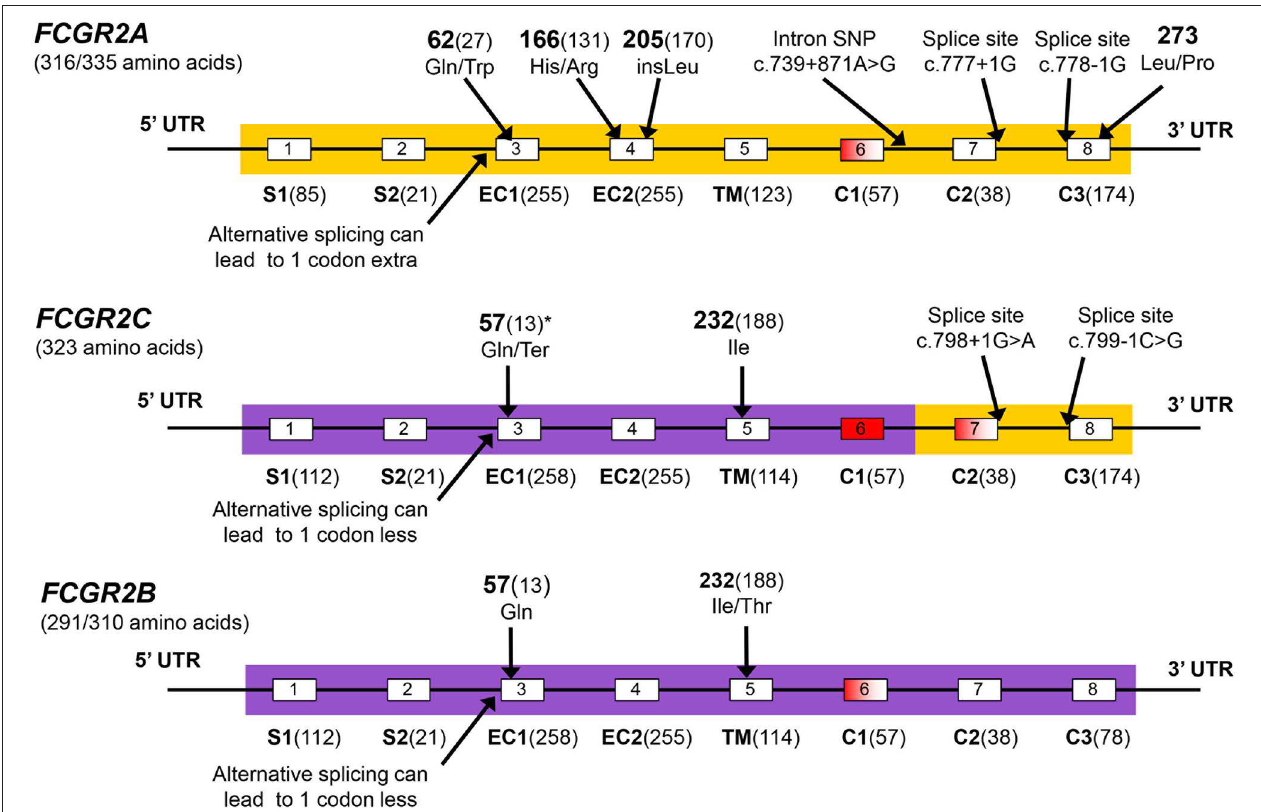
FIGURE 3 | FCGR2 exons. The FCGR2C gene is the crossover product from an unequal crossover between FCGR2A and FCGR2B . Coloring of FCGR2C matches the color of the other FCGR2 genes in the parts where it is highly homologous to that gene. Exons are shown by boxes, white exons are included in all transcripts, red exons are always spliced out, red-shaded exons are spliced out in some transcripts but retained in others. Exon names are below and followed by the number of coding base pairs in that exon. S1, S2, signal peptides; EC1, EC2, extracellular domains; TM, transmembrane domain; C1, C2, C3, cytoplasmic domains. The C3 exons contain an immunoreceptor tyrosine-based activation motif (ITAM) in FCGR2A and FCGR2C , and contains an immunoreceptor tyrosine-based inhibitory motif (ITIM) in FCGR2B . There is a potential confusion with regard to exon numbering in FCGR2 genes: In the FCGR2B gene, transcripts exist that do (FCGR2B1) or do not (FCGR2B2) retain the 57 bp exon6, dependent on the cell type in which the receptor is expressed. In FCGR2A and FCGR2C a very homologous exon6 is present on genomic level, but this exon is always spliced out in FCGR2A and FCGR2C transcripts. Only in some rare cases exon6 is retained in FCGR2A, which results in a gain-of-function Fc γ RIIA isoform (39). The final two exons of FCGR2A and - 2C are often designated exon6 and 7, but to reflect the homology between the 3 FCGR2 genes, we chose to include the potential exon6 in the nomenclature of all FCGR2 genes, designating the final 2 exons exon7 and 8. However, we do not include the base pairs of this exon6 when indicating the nucleotide positions in the FCGR2A and FCGR2C transcripts, because this is not normally done in the literature. In FCGR2A transcripts, further inconsistencies exist as a result of alternative splicing at the beginning of exon3 because of two adjacent splice acceptor sites that can both be used. The most commonly used nucleotide and amino acid numbering is derived from the shorter transcript in which the 3’ splice acceptor site is used, so we chose to use this transcript for nucleotide numbering throughout this thesis. Several SNPs are indicated in the figure, all are indicated by their amino-acid position in the full protein, followed by the amino acid position excluding signal peptides between brackets for some of the SNP which are commonly known by that position. *The p.Gln57Ter SNP in FCGR2C is part of a haplotype of 8 SNPs in intron2 and exon3 in FCGR2C , this whole haplotype is identical to FCGR2B in the case of p.57Gln (40). p57Gln is the only non-synonymous coding SNP in this